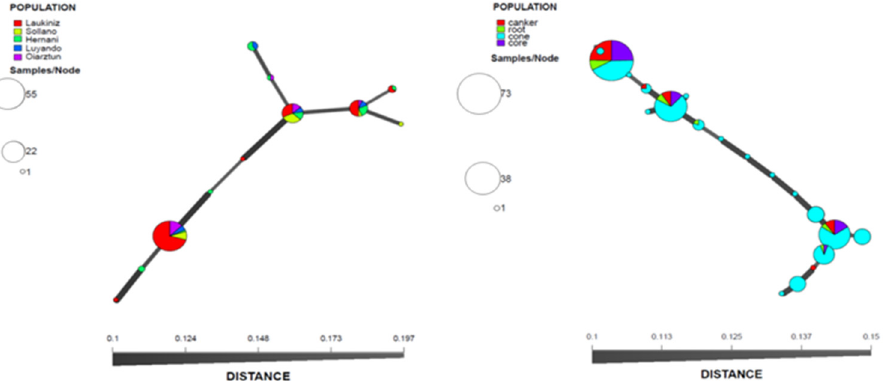
Figure 2. Minimum spanning network from the clone-corrected data showing the relationships among the individual multilocus genotypes (MLGs) found among populations defined by A. geographical location of the nurseries within the Basque Country and B. type of material. Each node represents a different MLG. The distances and thicknesses of the lines between nodes are proportional to Bruvo’s distance [63]. Node colors and sizes correspond to the population studied and the number of individuals, respectively.